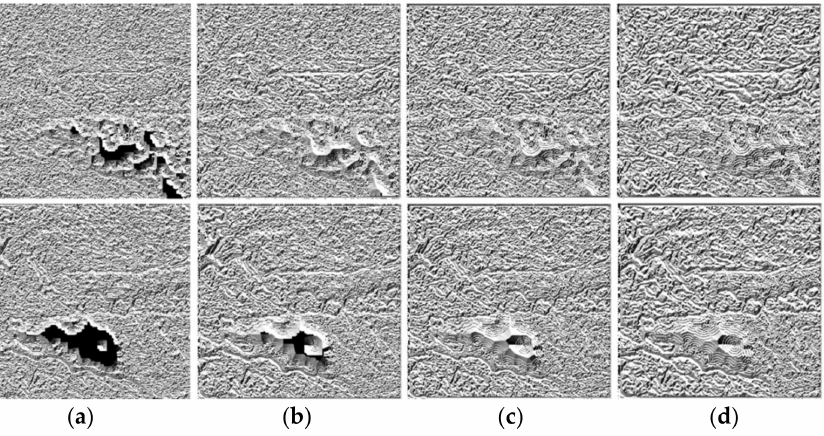
Figure 4. Results of new gradient direction: ( a ) The gradient direction of the original image pair; ( b ) The gradient direction of the image pair in first layer scale space; ( c ) The gradient direction of the image pair in second layer scale space; ( d ) The gradient direction of the image pair in third layer scale